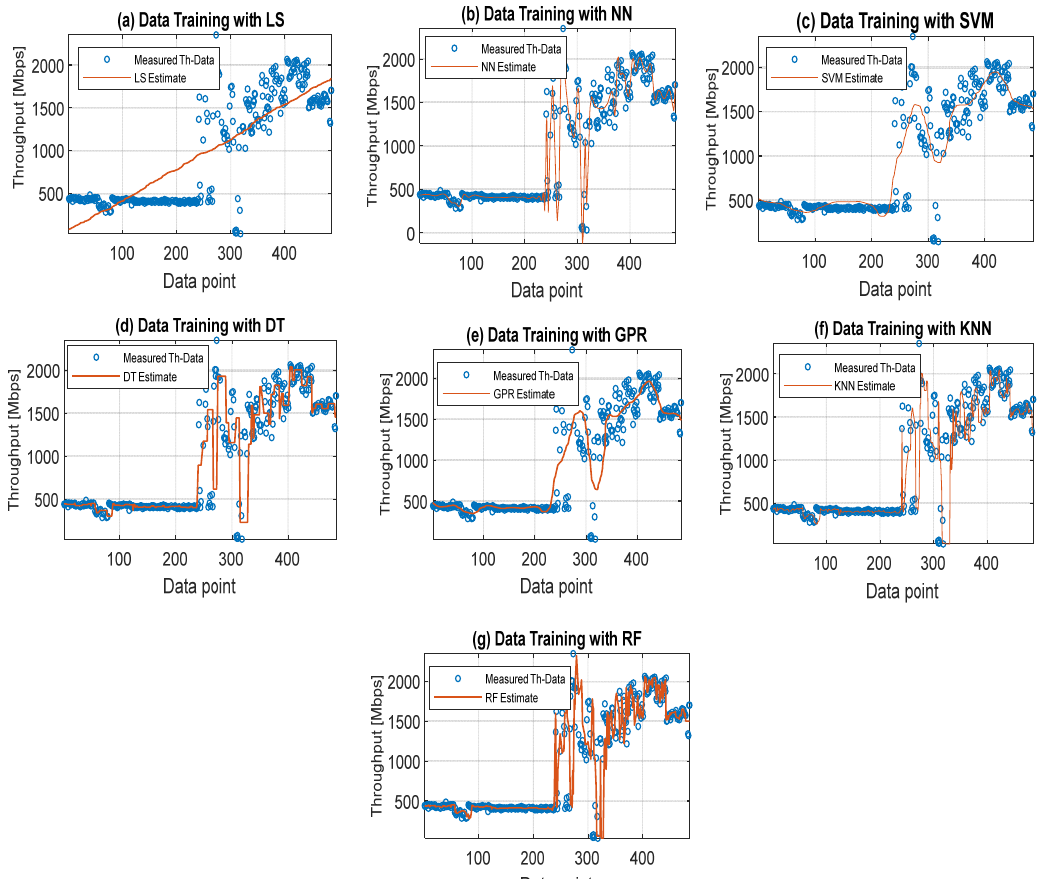
Figure 3. Throughput quality comparison of different machine learning models. ( a ) Least-squares (LS). ( b ) Neural networks (NNs). ( c ) Support vector machine (SVM). ( d ) Decision tree (DT). ( e ) Gaussian process regression (GPR). ( f ) K-nearest neighbor (KNN). ( g ) Random forest (RF).